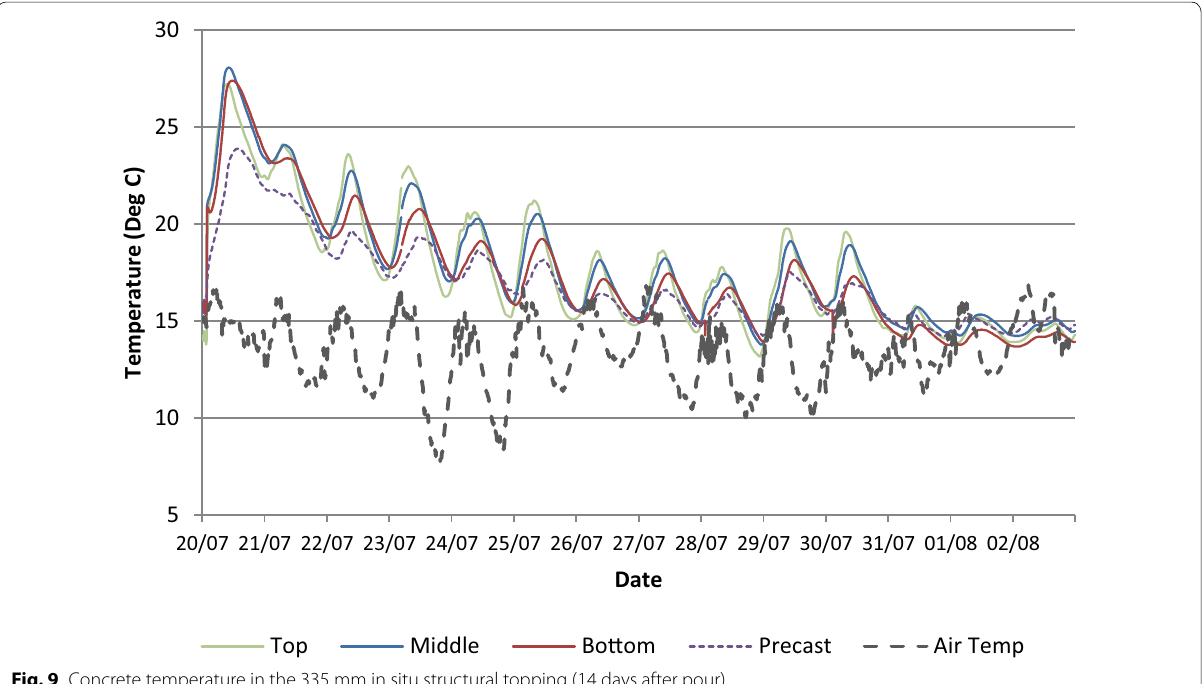
Fig. 9 Concrete temperature in the 335 mm in situ structural topping (14 days after